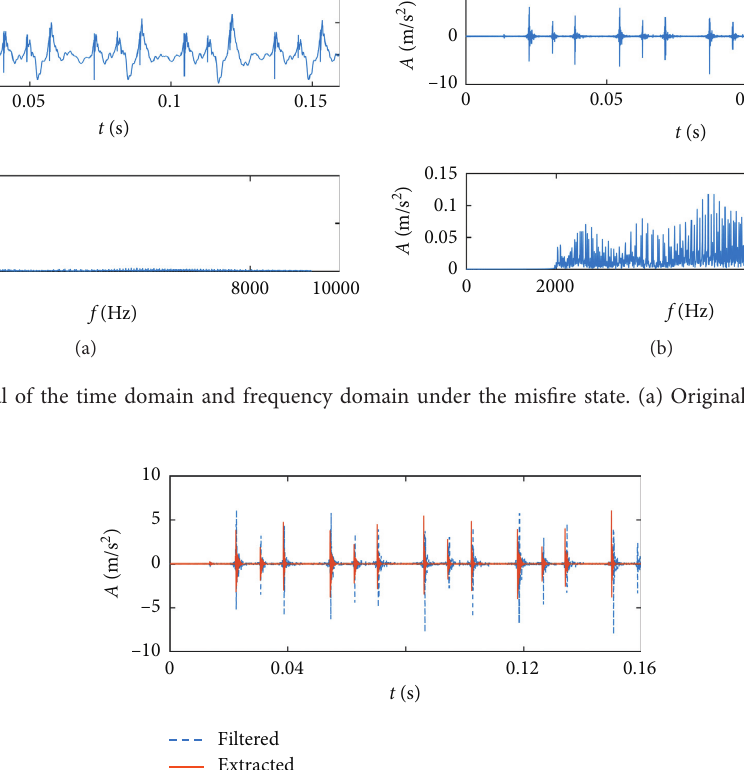
Figure 10: Filtered noiseless signal and extracted feature signal under the noiseless condition with single-cylinder misfire fault.